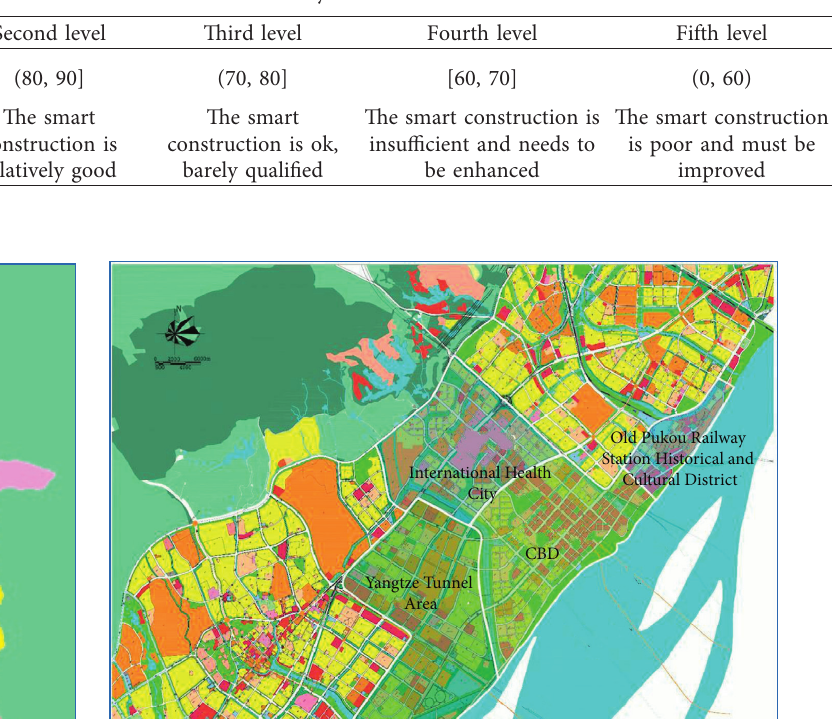
Table 6: CBD classification system.